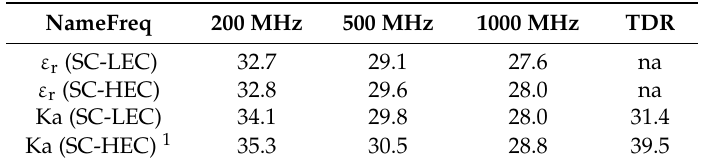
Table 1. Table of measured permittivity by the new probe design using a standard network analyzer. Shown are results from measurements at 200, 500, and 1000 MHz. Also shown in the last column are predicted values for Ka from TDR measurements performed higher up in the soil test-column. Of importance is to note that TDR provided significantly different readings depending upon the salinity content (all readings were on saturated